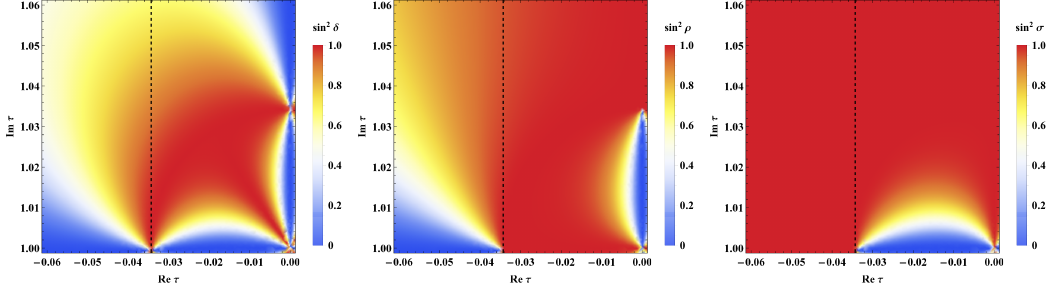
Figure 2 . The 3 σ allowed regions of { Re τ, Im τ } and { mate analytical formulas of three neutrino masses and mixing angles are represented by blue shaded areas. For comparison, the allowed regions obtained by exact numerical calculations are plotted in red.